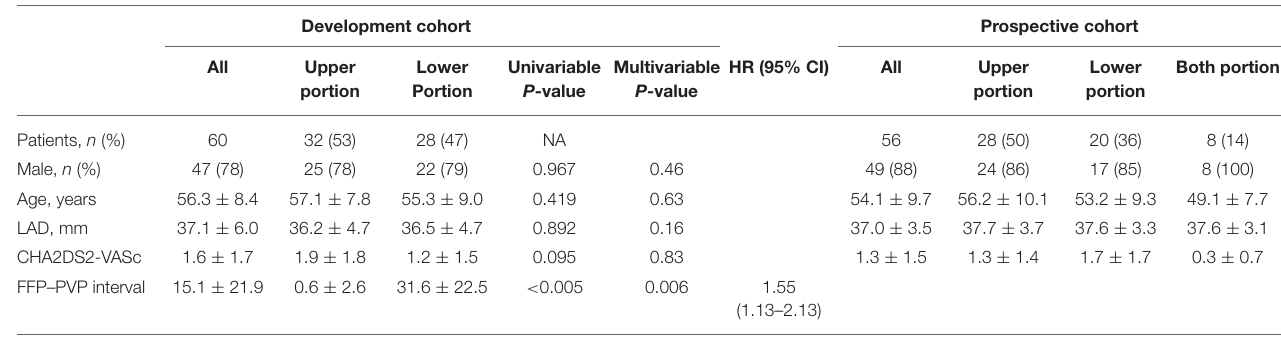
TABLE 1 | Baseline characteristics of patients in the development and prospective cohorts.